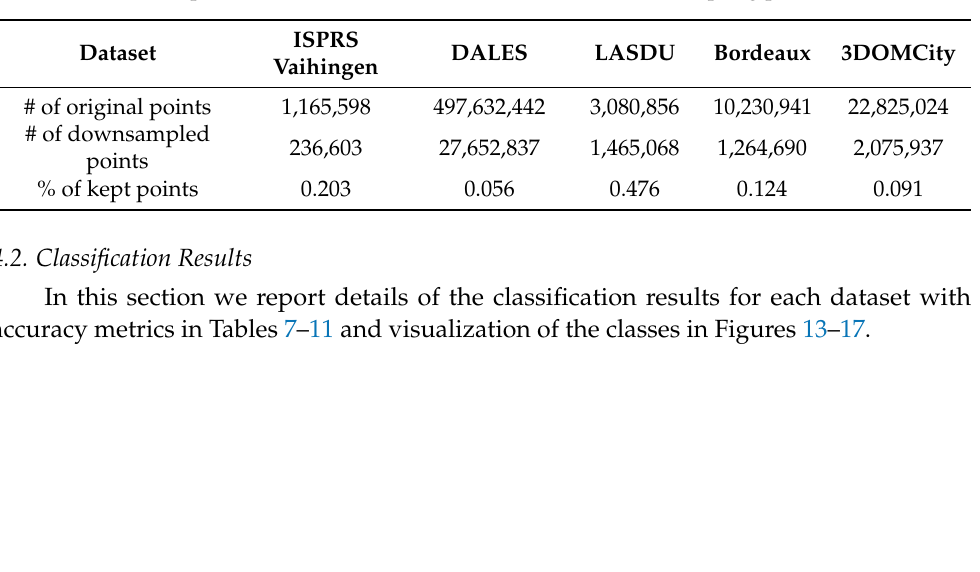
Table 6. Number of points in each dataset before and after the downsampling